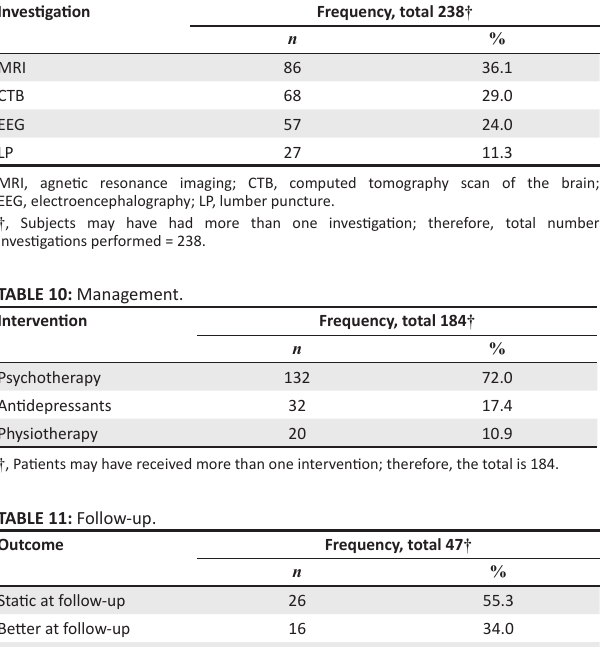
TABLE 9: Investigations performed. Investigation